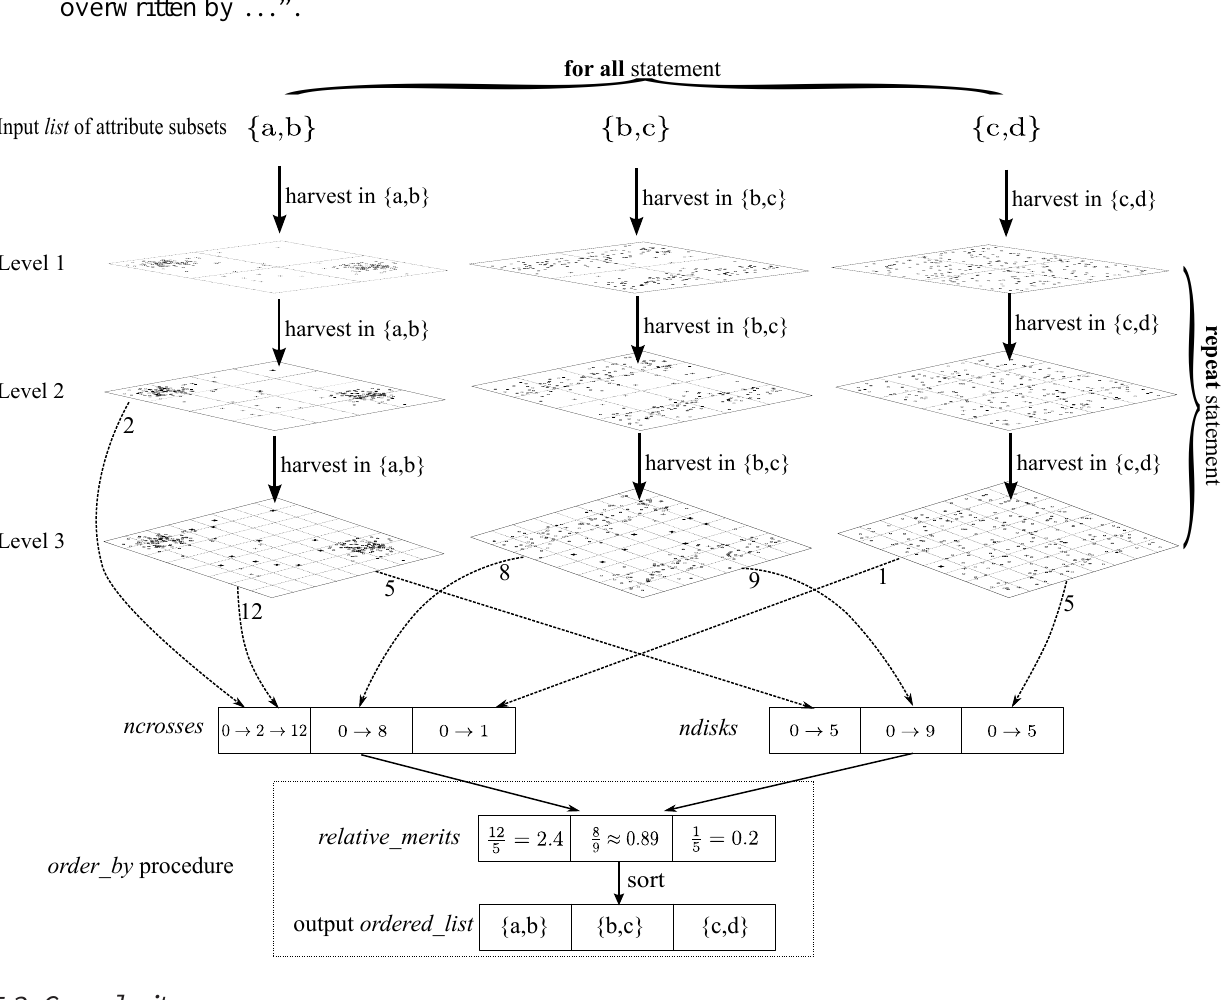
” means “the variable is →